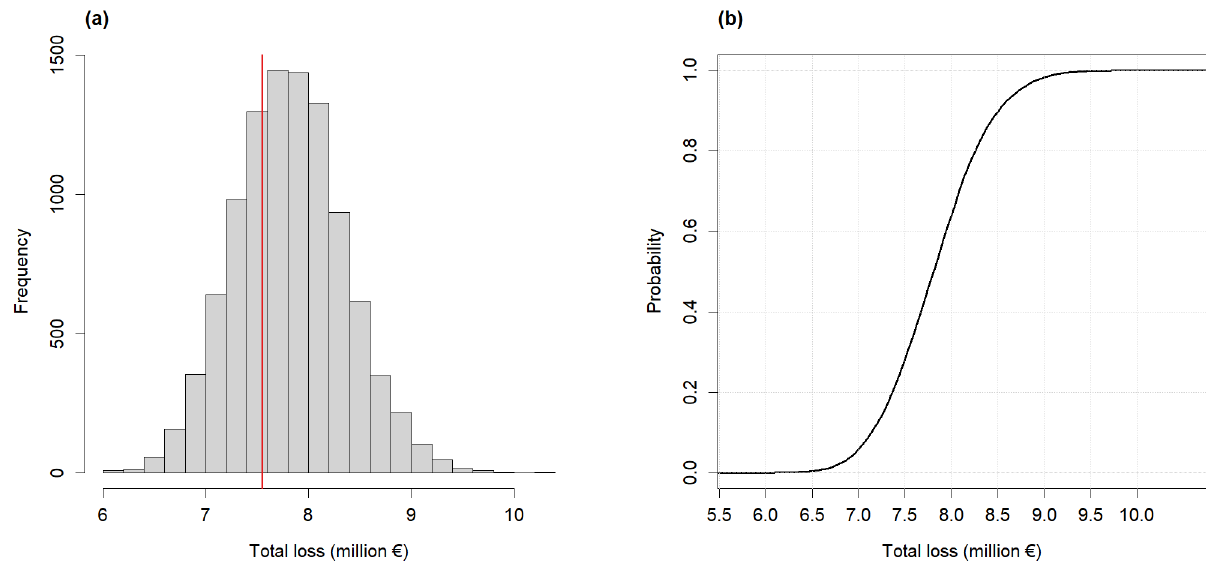
Figure 9. Probabilistic estimates of total loss, relative to model uncertainty, for the Caldogno application case, based on 10000 realisations of loss to each building. (a) Histogram, with observed loss shown by the vertical red line. (b) Empirical cumulative distribution function